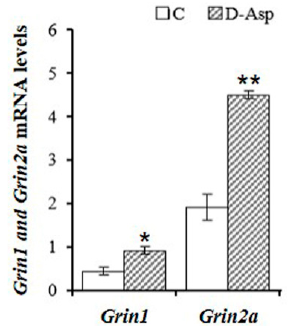
Figure 1. Quantitative Real Time-PCR (qRT-PCR) analysis of NMDAR subunits ( Grin1 and Grin2A ) in the testis from D -Asp-treated rats (chronic treatment) and controls (C in the figure). Values represent the mean ± SD of five samples. ** p < 0.01 and * p < 0.05. Further, several pieces of evidence indicate that NMDAR activation induces phosphorylation of MAPK [32]. MAPK is a serine/threonine kinase that occupies a focal point in signal transduction, mainly by activating gene transcription via translocation to the nucleus [33]. NMDAR-dependent MAPK-signaling triggers new gene expression [34]. In the rat testis, D -Asp administration elicited MAPK1 and MAPK3 phosphorylation (P-MAPK1 and 3; more commonly known as P-ERK2 and 1, respectively) [13]. Immunolocalization of P-MAPK 1 or 3 in the interstitium suggests that activation of cAMP and/or MAPK pathways by D -Asp through binding to NMDAR could be involved in steroidogenesis [13]. Previously, cAMP has been implicated as second messenger for the synthesis of T [35,36]. Topo and coworkers [12] reported that rat Leydig cells incubated at 37 °C for 60 min with 10 mM D -Asp showed a five-fold increase of cAMP levels.